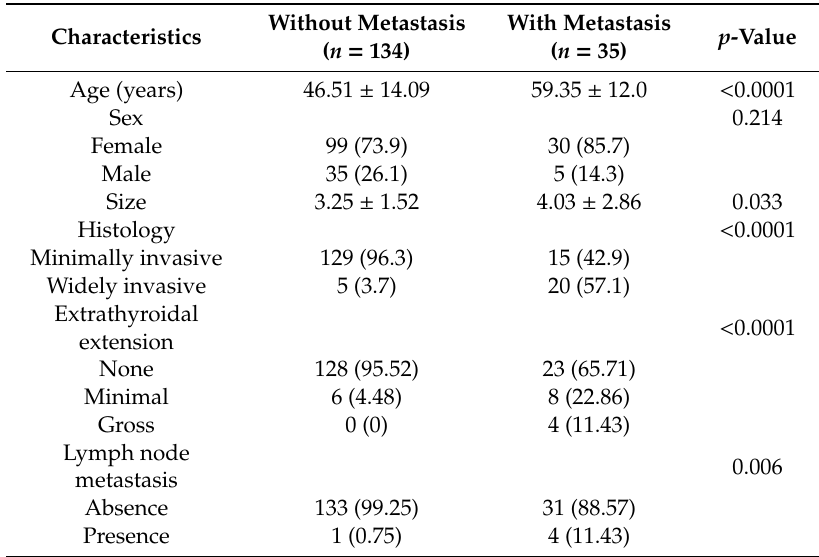
Table 1. Clinicopathologic characteristics of the 169 patients with follicular thyroid carcinoma with and without distant